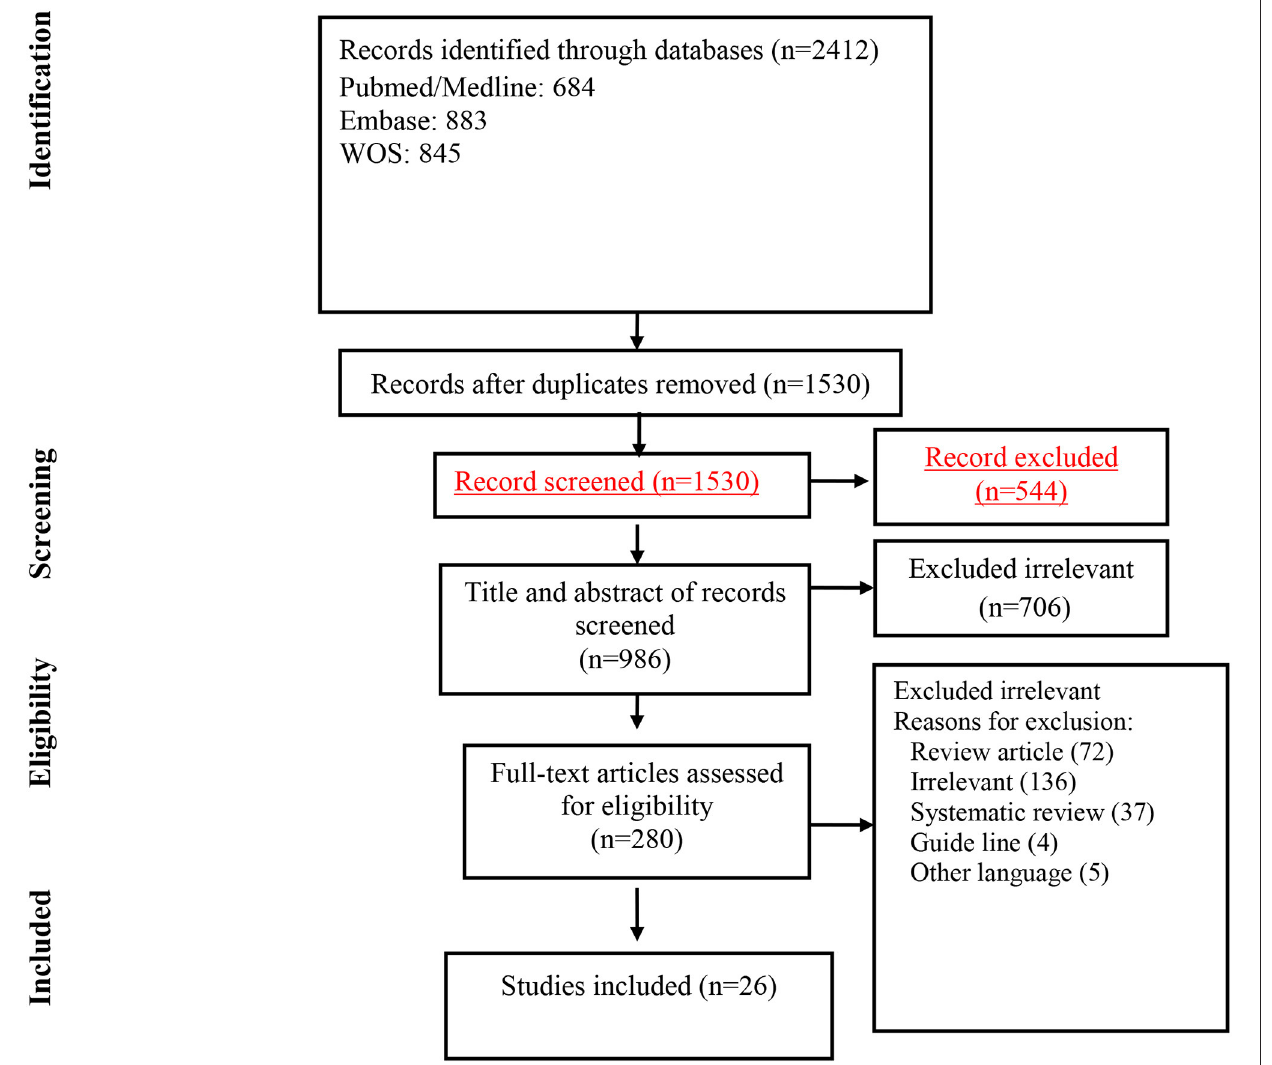
FIGURE 1 | Flow chart of study selection for inclusion in the systematic review and meta-analysis.